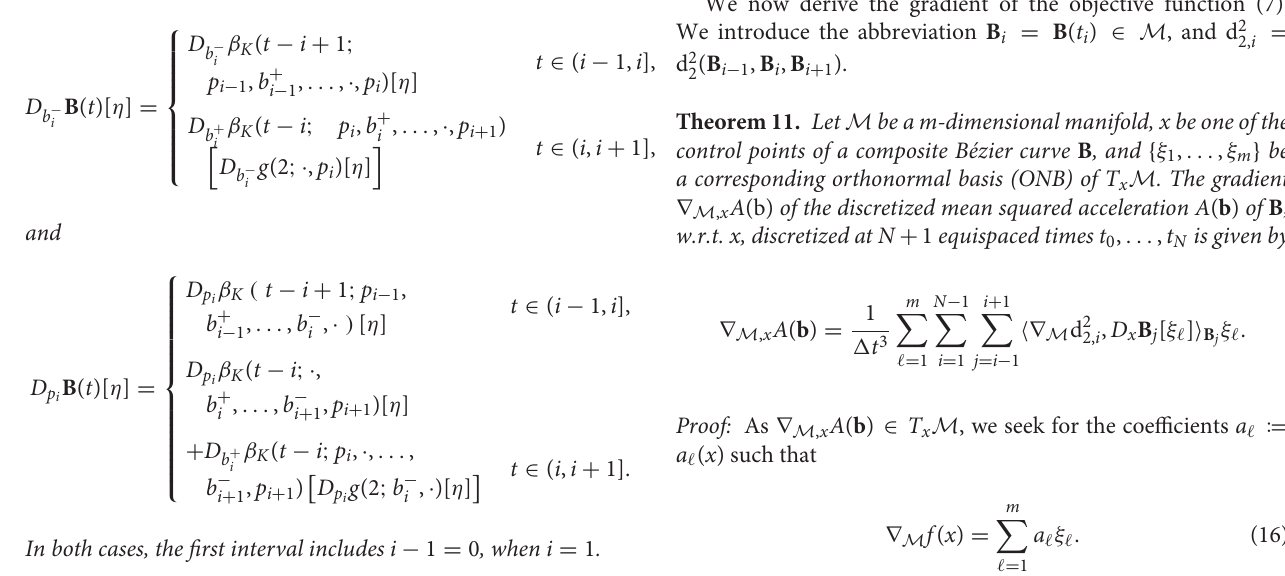
b 0 , b 1 , b 2 , b 3 ). The derivative with respect to a variable b i is obtained by a recursion of Jacobi FIGURE 6 | Construction and derivation tree of a Bézier curve β 3 ( t ; fields added at each leaf of the tree. (A) Tree-representation of the construction of a cubic Bezier curve. The thick line tracks the propagation of b 1 within the tree. D b β 3 [ η ]. The solid lines are Jacobi fields while dashed lines are reversed Jacobi (B) Tree-representation of the construction of η [3] 0 : 1 =